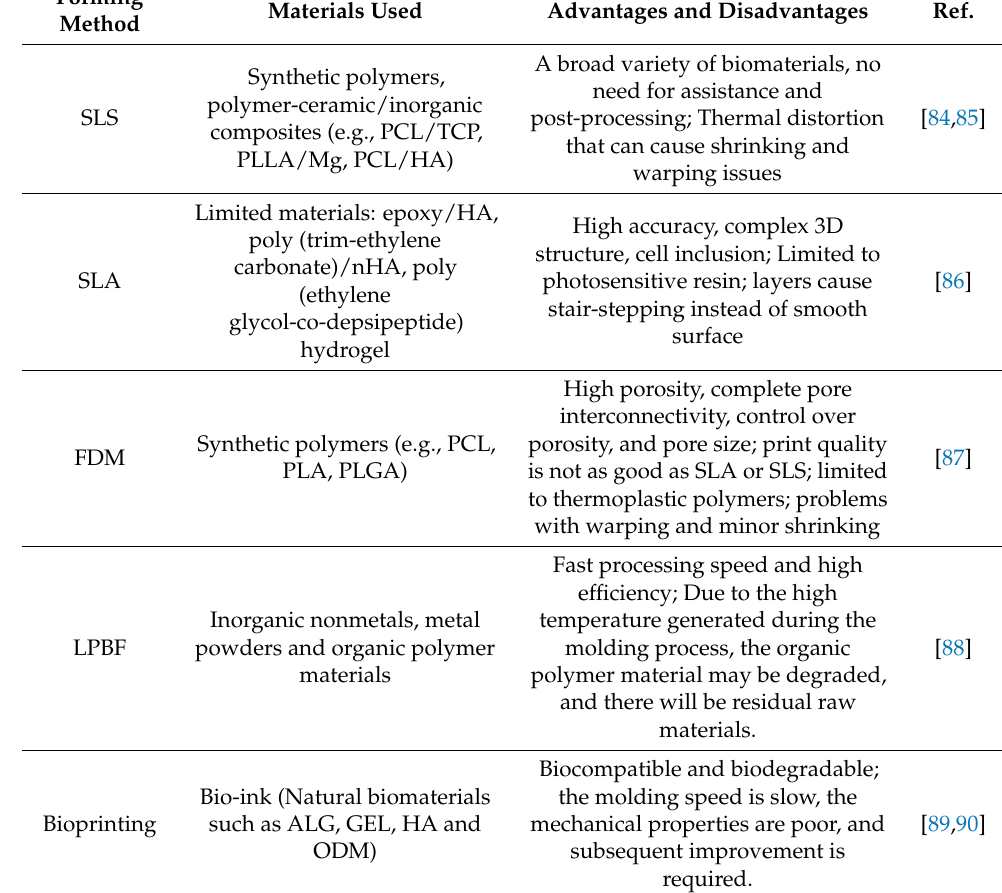
Table 2. Introduction of widely used bone implant molding methods based on 3D printing technology